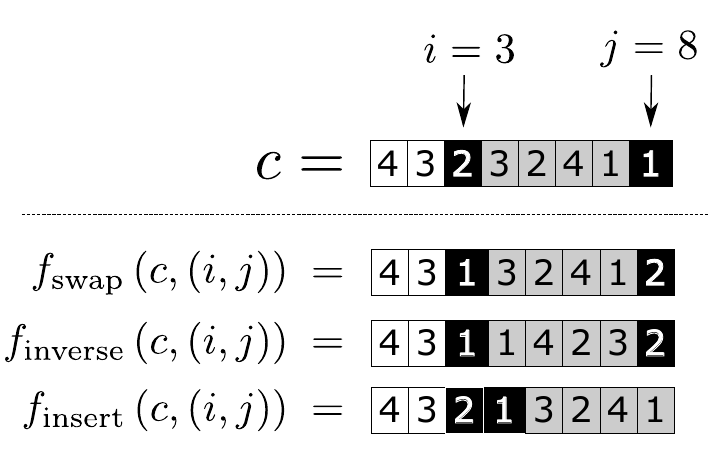
Figure 3. Scheme of mutation